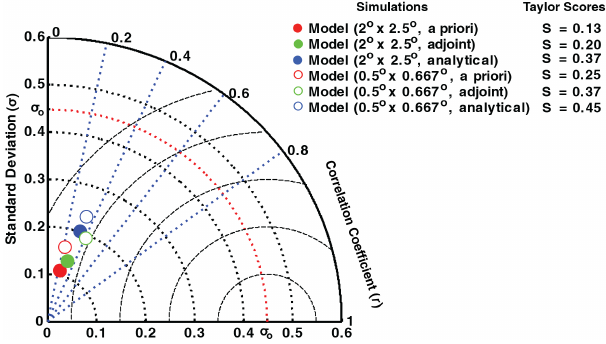
Figure 12. Taylor diagram and Taylor scores for GEOS-Chem sim- ulations of BC for July–September 2006 at 2 ◦ × 2.5 ◦ (solid cir- cle) and 0.5 ◦ × 0.667 ◦ (open circle) with the a priori (red circle) or a posteriori emissions from the analytical (blue circle) or adjoint (green circle) inversions. Values are averages for the 69 IMPROVE sites (Fig.